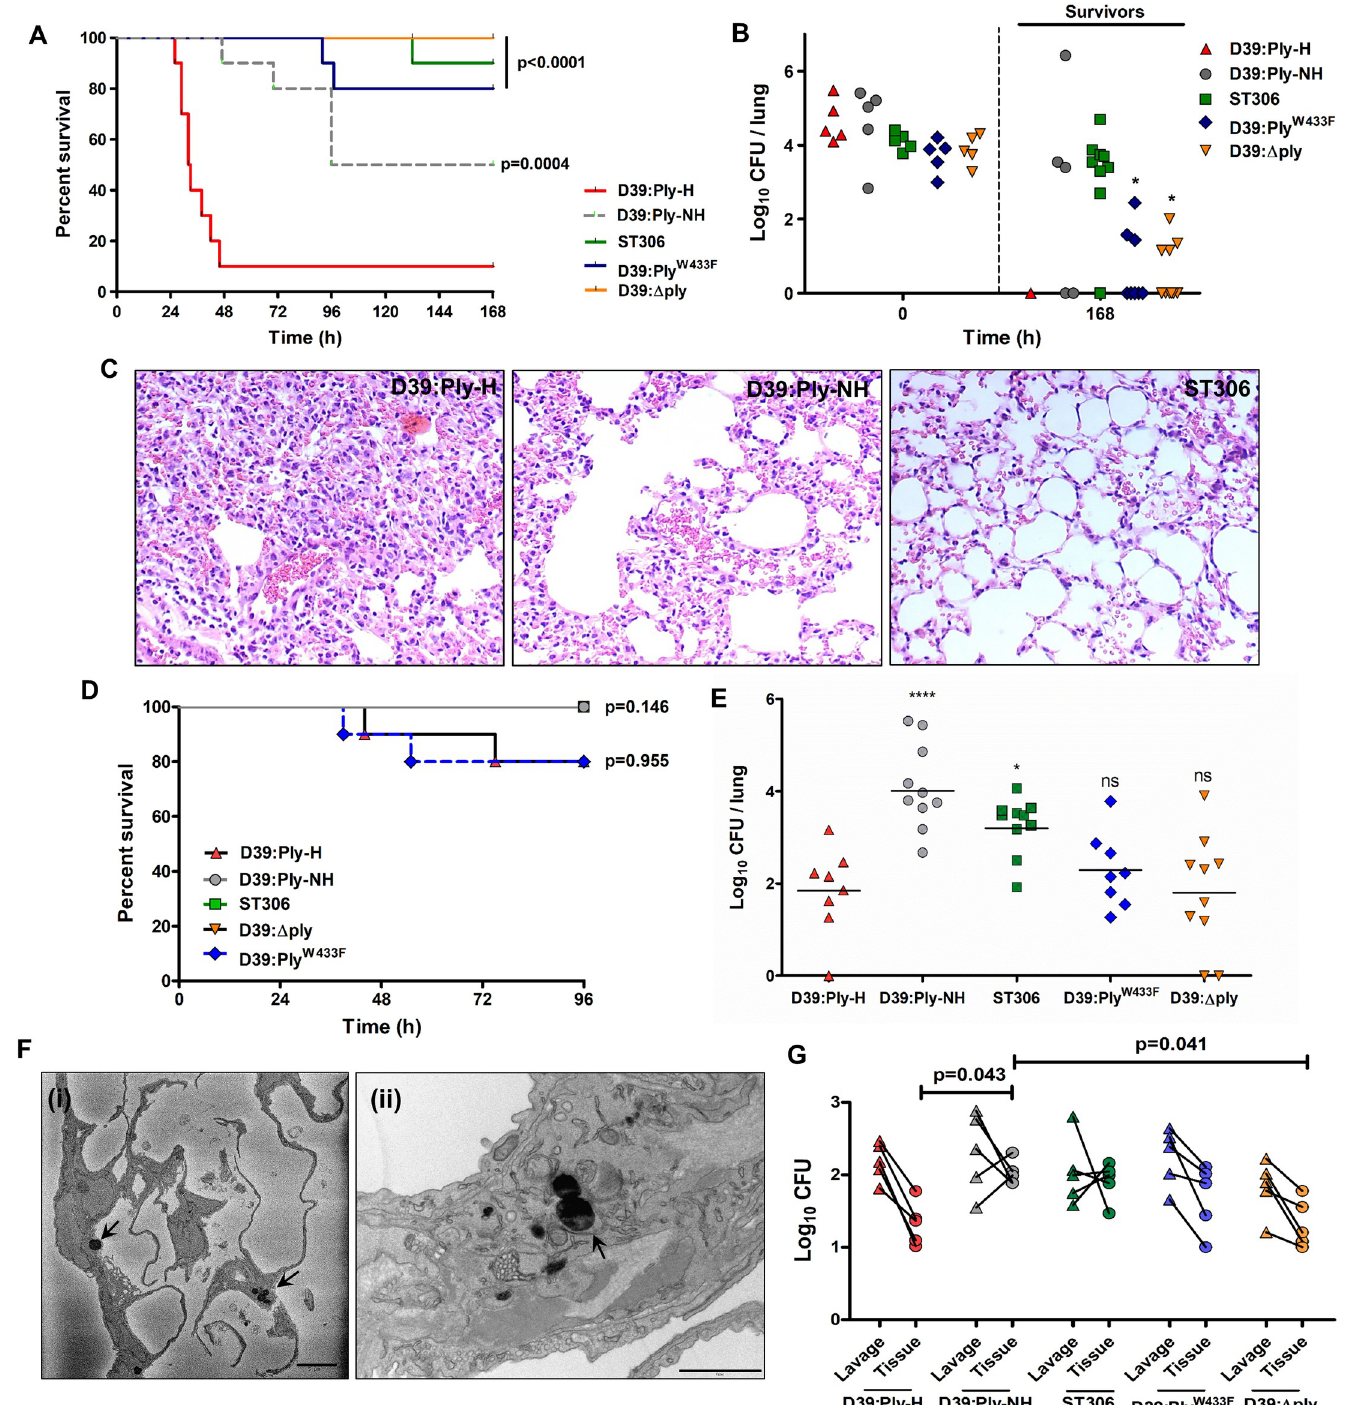
Fig 6. Ply-NH attenuates virulence of SPN and enables host tolerance and an intracellular lifestyle in the lower respiratory tract. ( A ) Survival time (h) of CD1 mice infected intra-nasally with 1.5 × 10 6 CFU of D39:Ply-H, D39:Ply-NH, D39: Δ Ply (Ply deletion mutant), D39:Ply W433F (mutant strain expressing a non-hemolytic Ply) or serotype 1 ST306. n = 10 mice per group. p -values are from Log-rank test vs D39:Ply-H, with Bonferroni correction applied for multiple comparisons. ( B ) CFU in lungs immediately following infection (0 h, n = 5 mice per group) and in surviving mice from (A) at 168 h.p.i. p- values are from two-way ANOVA analysis with Dunnett’s multiple comparisons test vs D39:Ply-NH. ( C ) Histopathology of H&E stained lung tissue samples of mice infected with D39:Ply-H, D39:Ply-NH, or ST306 SPN strains at 24 h.p.i. Magnification: 20X. ( D ) Survival time (h) of CBA/Ca mice infected intra-nasally with 1 × 10 6 CFU of D39:Ply-H, D39:Ply-NH, D39: Δ Ply, D39: